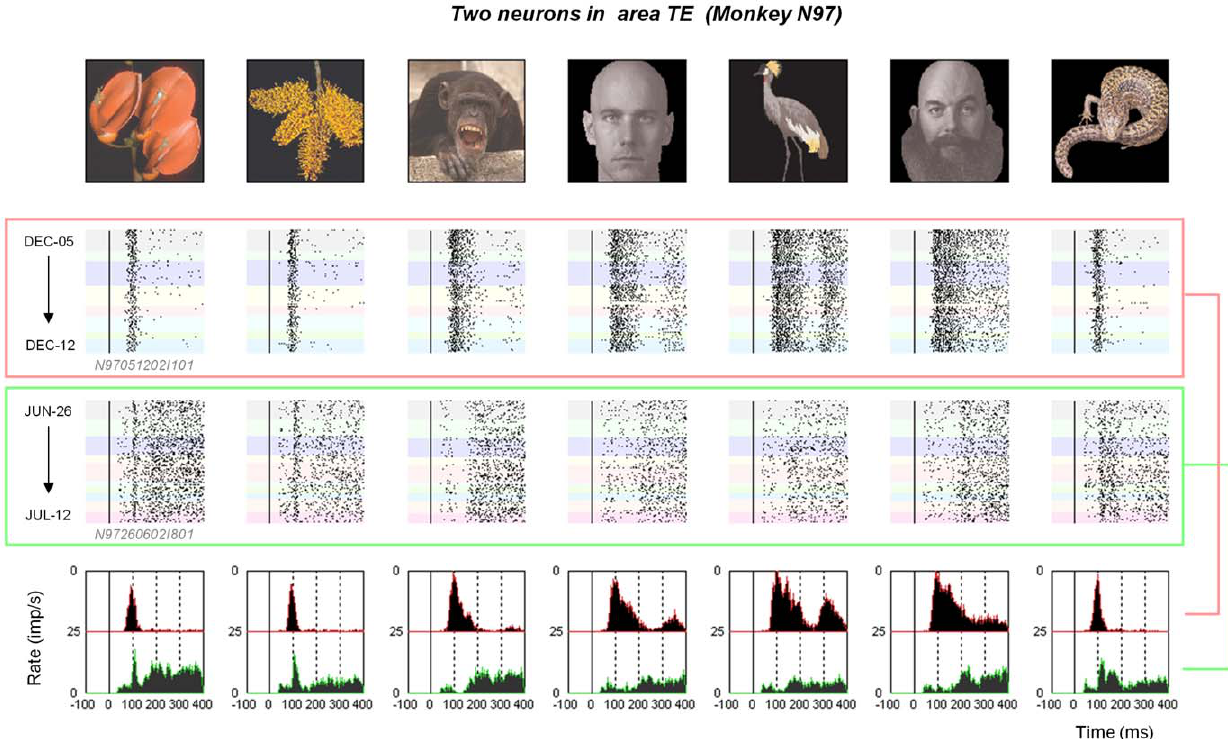
Figure 1. Single unit responses in area TE. Data are shown from two neurons from monkey N97. The two neurons were recorded on two different microwires (channels of electrodes bundle marked as I1 and I8) and during two different time periods. Directly below each image, the action potential responses are shown over a period of several days, with each background color corresponding to data collected from a different session. The diverse responses appear to be stable over the recording periods. At the bottom are the corresponding peristimulus time histograms for the two neurons.